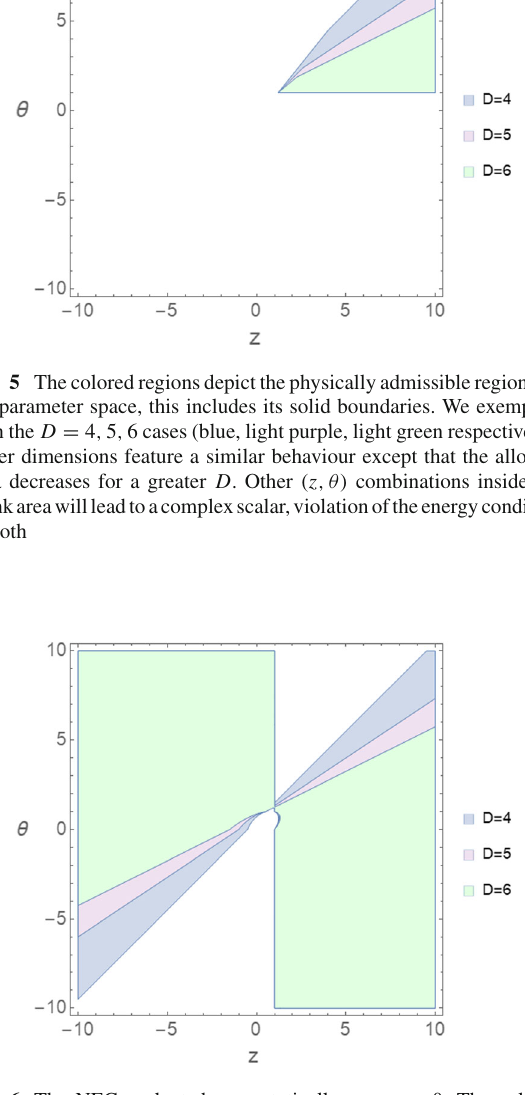
nario can be recovered asymptotically from our solution. A